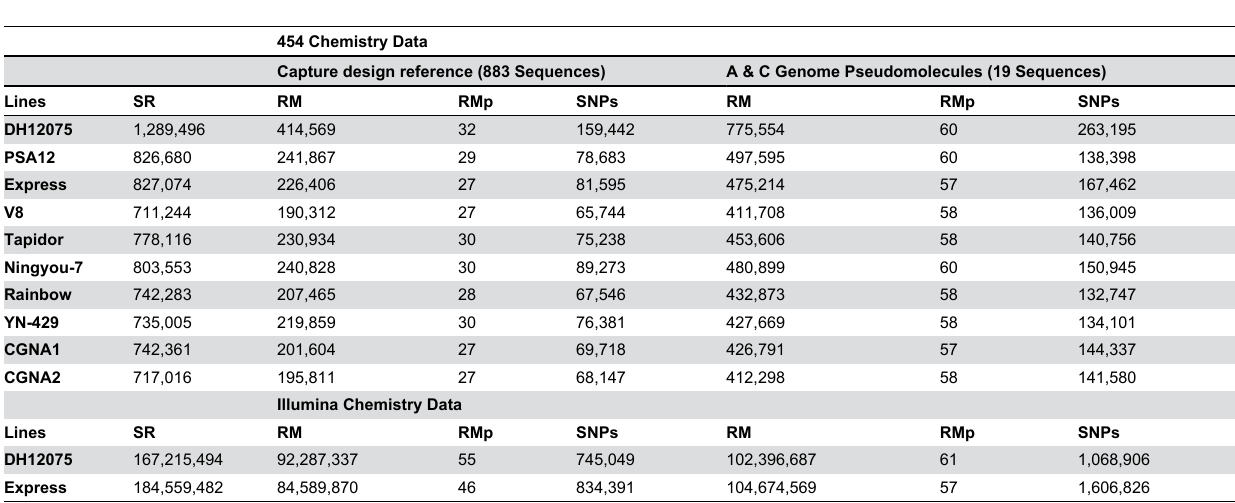
Table 2. Result summary of sequenced reads mapped against the A and C Brassica genomes.